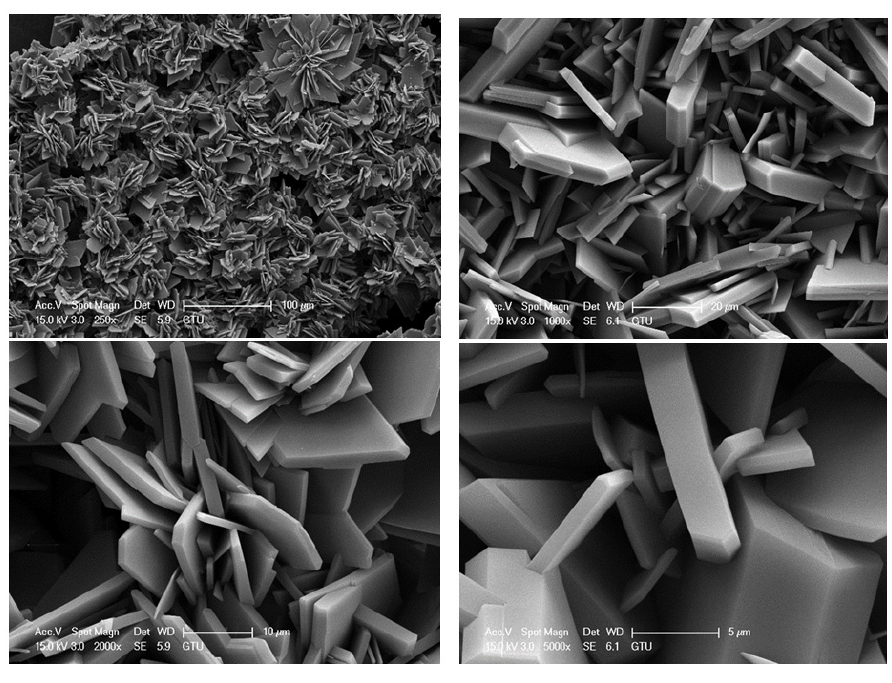
Figure 2. SEM images of the GTU-3.